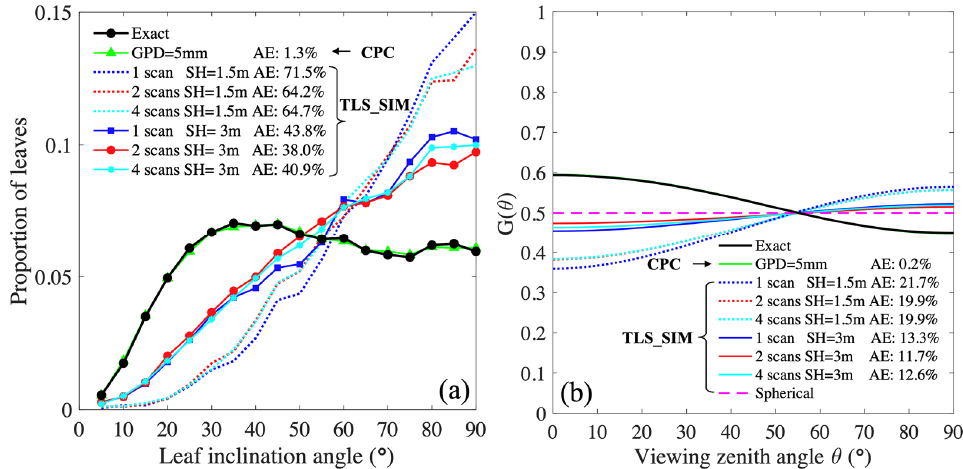
Figure 7. The effects of the number of scans and the scanner height on the leaf angle distribution (LAD) ( a ) and the G-function ( b ) for Tree3: the “Exact” curves in black are the true LAD and G- function computed from the three-dimensional (3D) tree model; the green curve is the LAD and the G-function computed from the complete point clouds (CPC) with a grid point distance (GPD) of 5 mm, which can represent the accuracy of the method without the occlusion effect; TLS_SIM denotes simulated TLS point clouds. The scanning strategy is illustrated in Figure 1(d3).